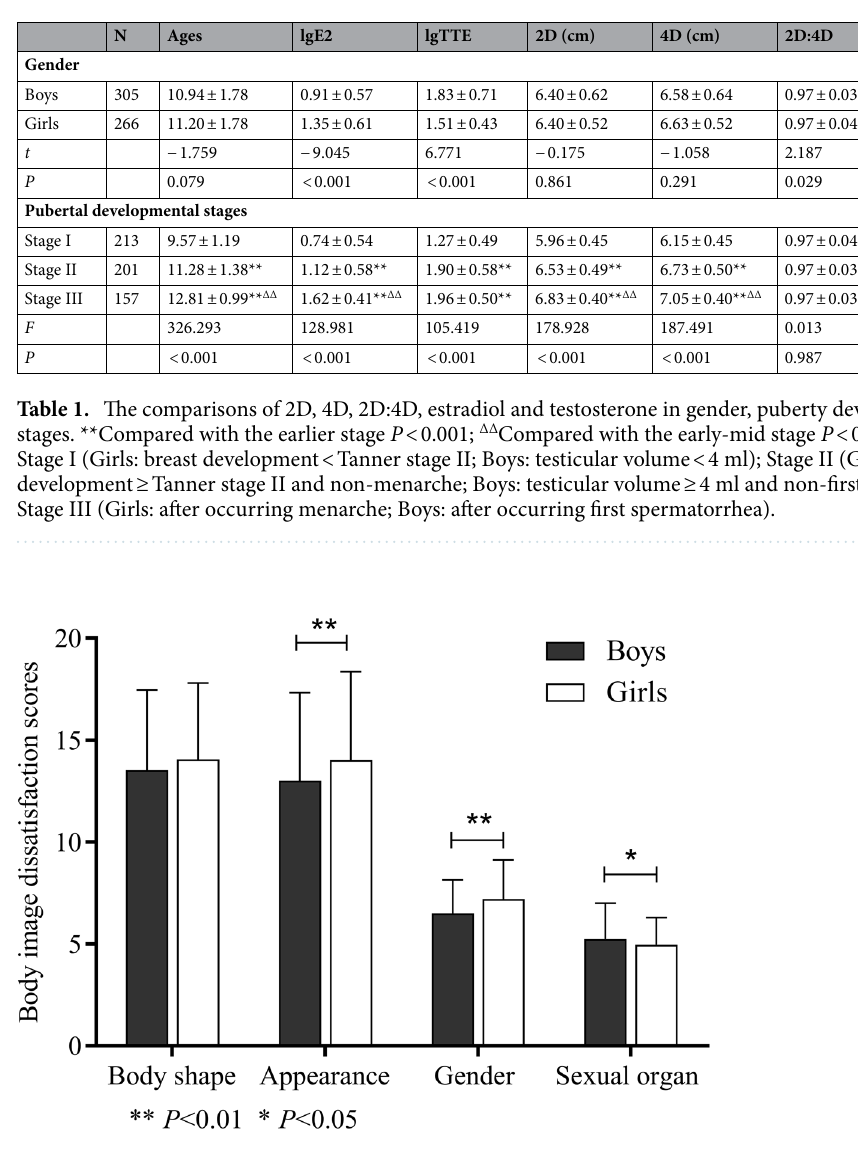
Figure 1. The comparison of body image dissatisfaction scores between